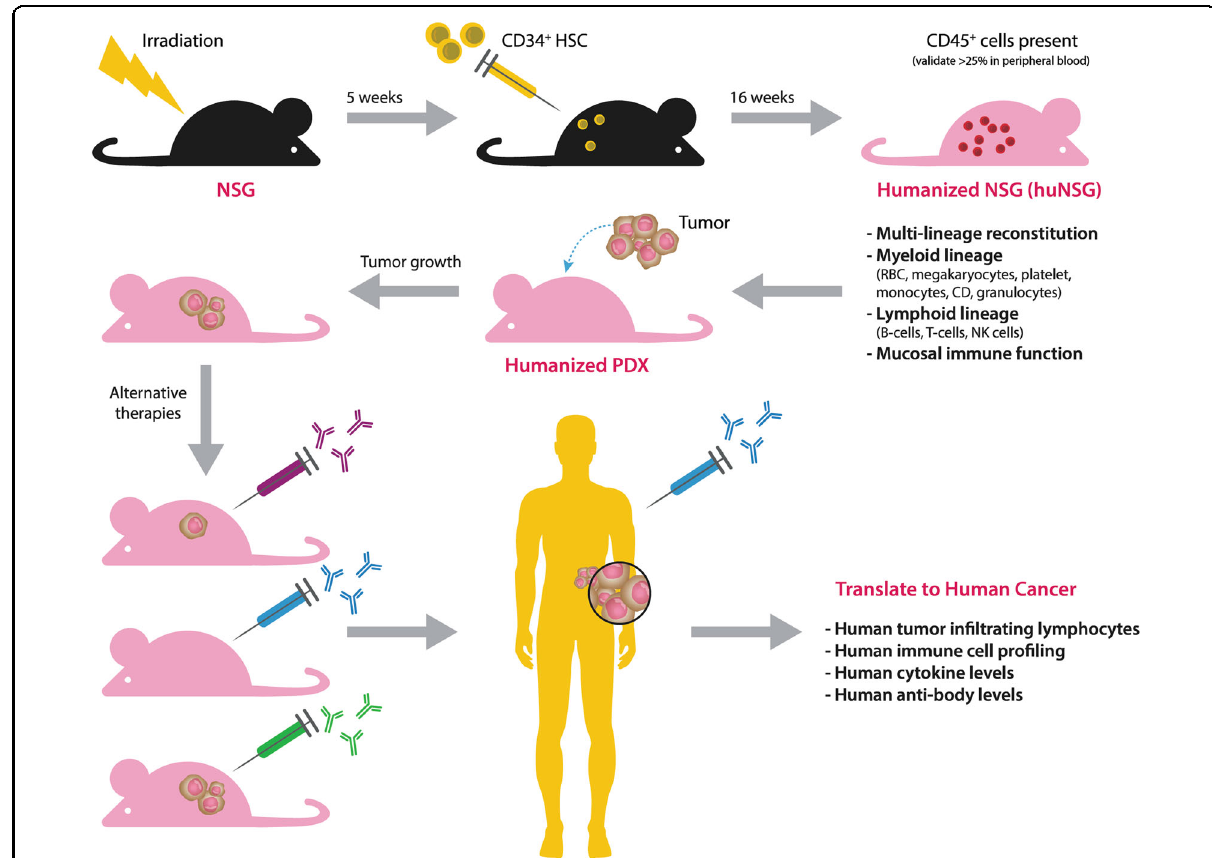
Fig. 3 Generation of humanized mice for immunotherapy models. The NSG mice are irradiated with whole body gamma irradiation. Human CD34 + hematopoietic stem cells (HSCs) are intravascularly injected into NSG mice at 5 weeks. Humanization for the engraftment of human HSCs is monitored by fl ow cytometry of use for determining the percentage of differentiated human CD45 + cells in the peripheral blood of the mice. Patient tumor tissues are then engrafted into ‘ humanized ’ mice and used for studying the ef fi cacy of variety therapies. These humanized PDX models can also permit the study of human immune responses, including the analysis of TILs, cytokines, and